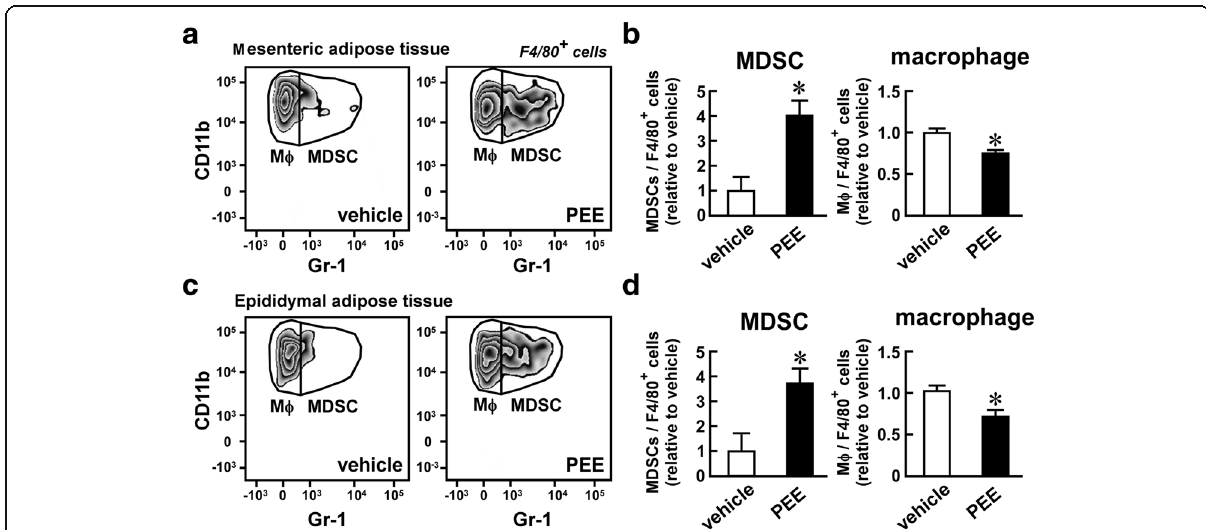
Fig. 2 Effects of PEE on the number of macrophages and MDSCs in the visceral adipose tissue of high fat diet (HFD)-fed mice. HFD-fed C57BL/6 mice were intraperitoneally injected with PEE (100 mg/kg, twice weekly) or vehicle for one month. Subsequently, ( a , b ) mesenteric and ( c , d ) epididymal adipose tissue were subjected to FACS analysis of macrophages and MDSCs. a , c Representative FACS images of four replicates. Only F4/80 + living cells are shown. b , d Proportion of macrophages and MDSCs in F4/80 + myeloid cells from ( b ) mesenteric and ( d ) epididymal adipose tissue. Data represents means ± SD of four samples. * P < 0.05 vs. vehicle-treated mice